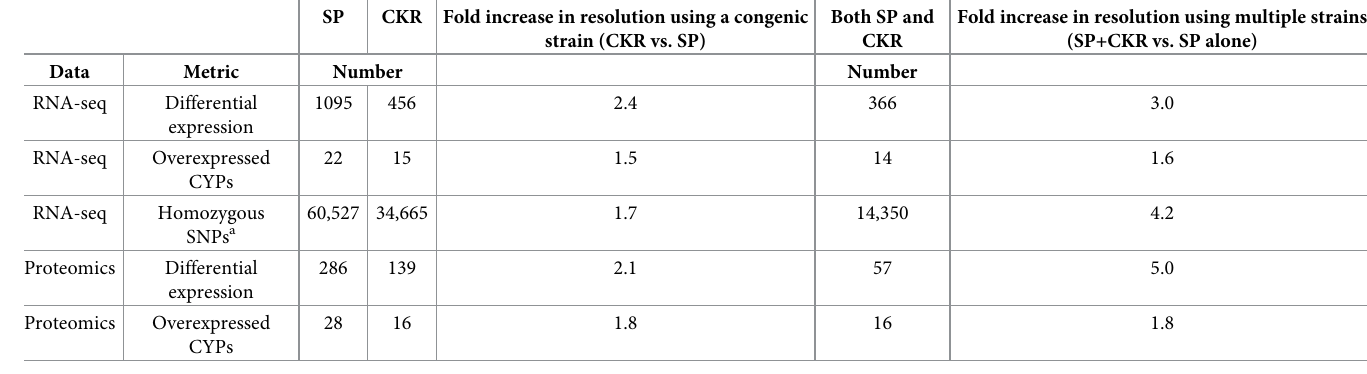
Table 4. Comparison of differences found in the RNA-seq and proteomics studies using an unrelated resistant strain, a congenic resistant strain, or both. SP CKR Fold increase in resolution using a congenic strain (CKR vs. SP)